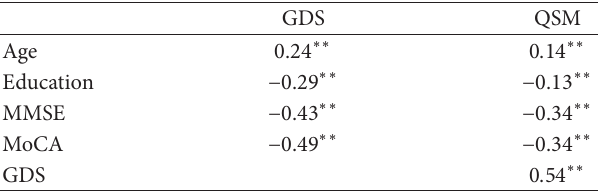
Table 3: Correlation for the main variables and